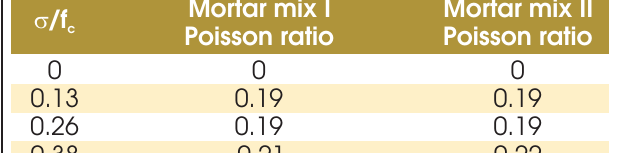
Figure 19 – Relation between the stresses of the numerical model for the mortar and block for mix